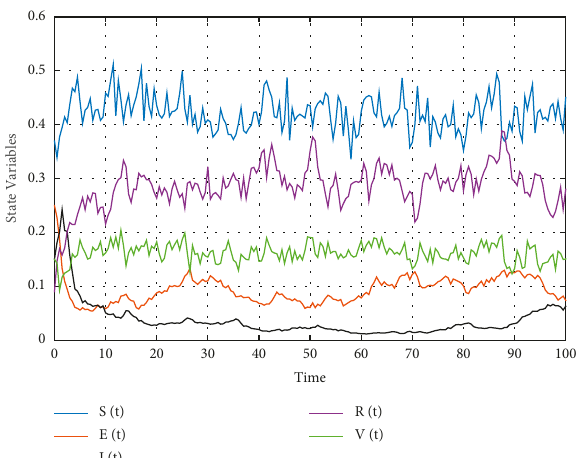
Figure 2: Numerical simulations of model (4), which shows that model (4) has a unique ergodic stationary distribution where the disease is persistent and 􏽢 R > 1 with ] i � 0 . 01, i � 1 , .. . , 5. 0